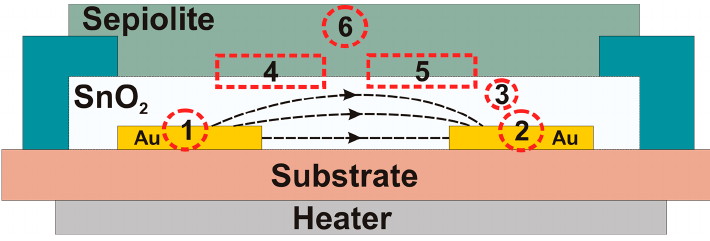
Figure 7. The cross-section of the structure of a thick-layered gas sensor based on tin dioxide (IV) with a sepiolite filter with indicated phase borders.